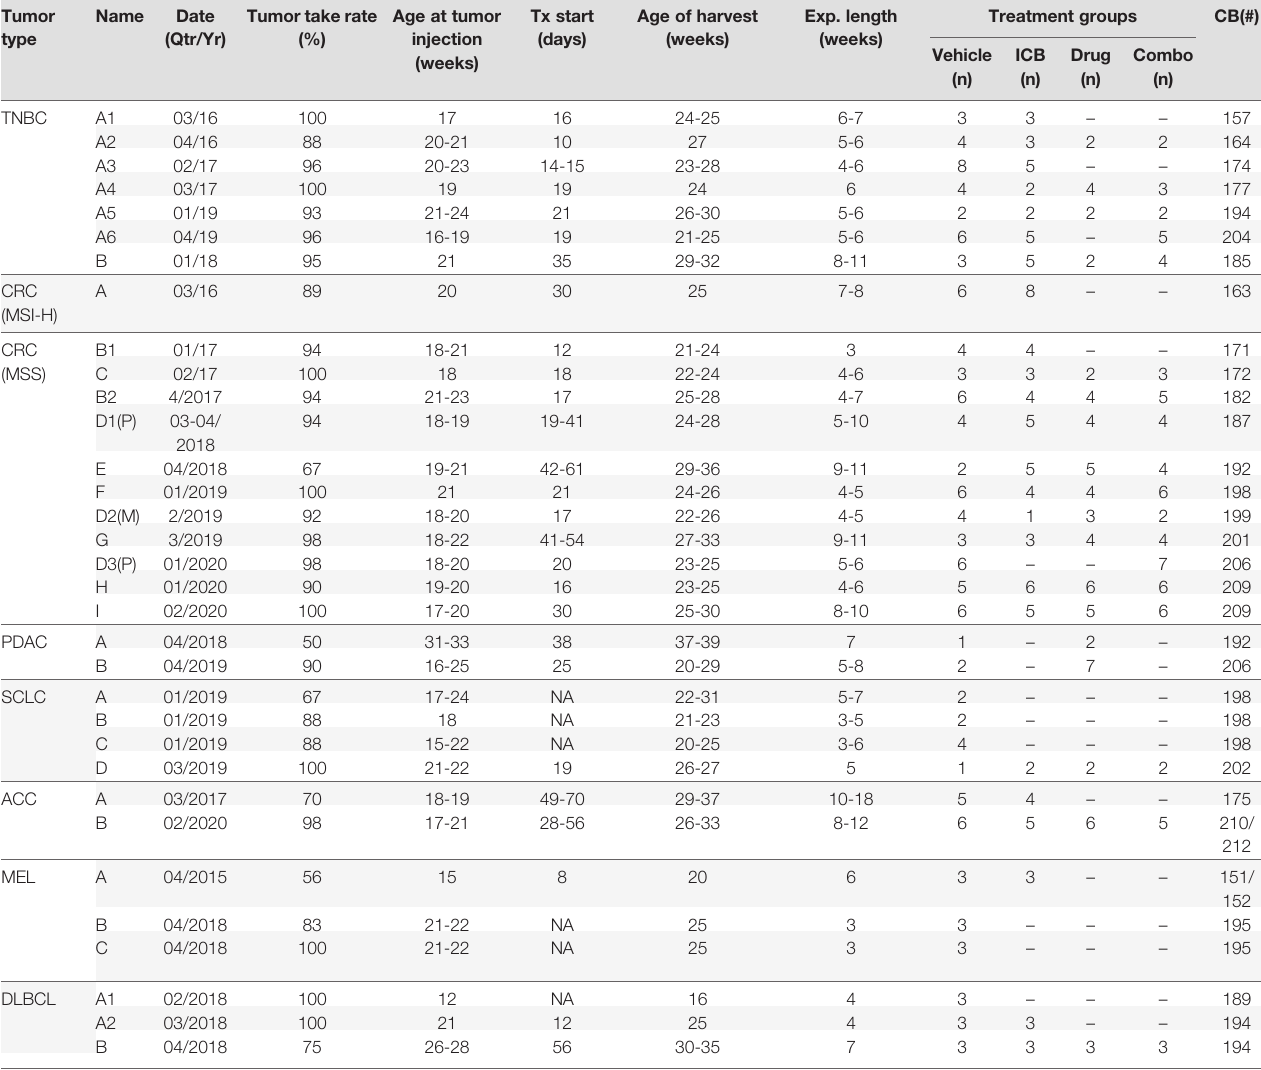
TABLE 2 | Experiment nomenclature and details for HIS-BRGS mouse study. Tumor type